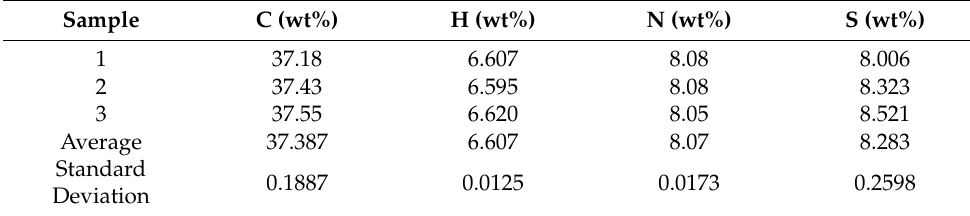
Table 1. Ultimate analysis of copolymer PADAD.